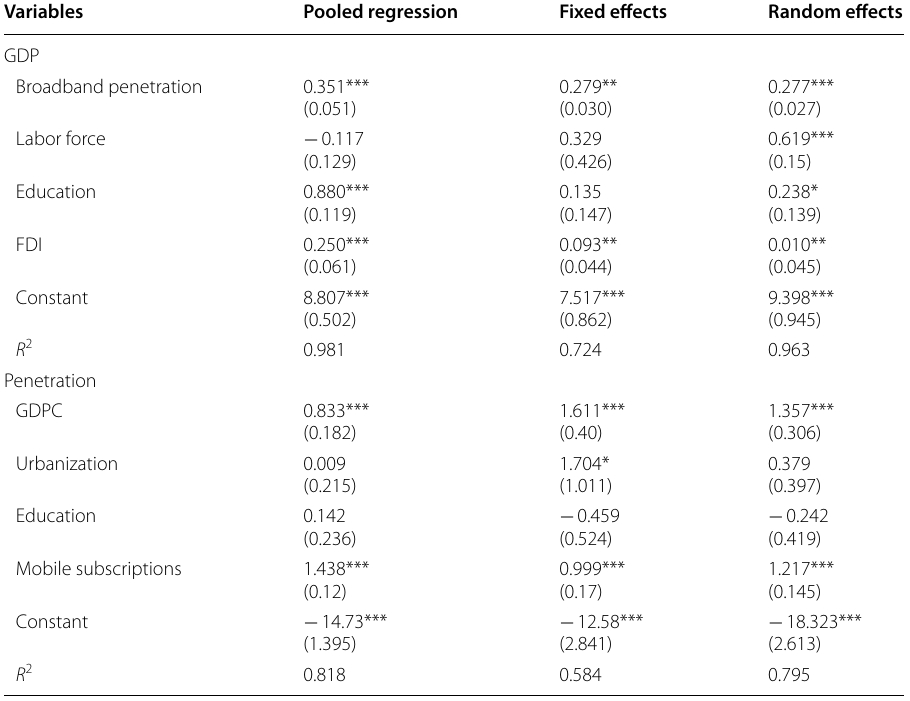
Table 3 Estimates of pooled, fixed effect and random effect 2SLS regressions (production and demand